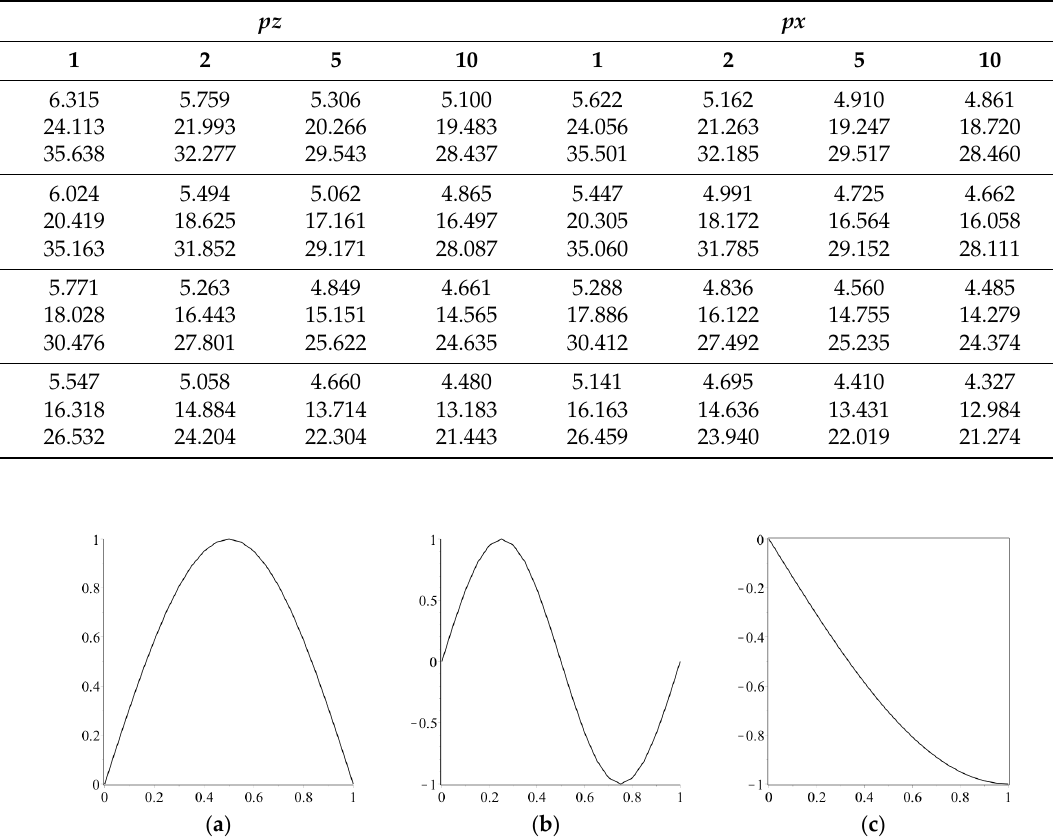
Figure 5. FGM1-Z nondimensional frequencies ( Ω (cid:2911)(cid:2914)(cid:2919)(cid:2923) ) for different vibration modes. L/h = 10.